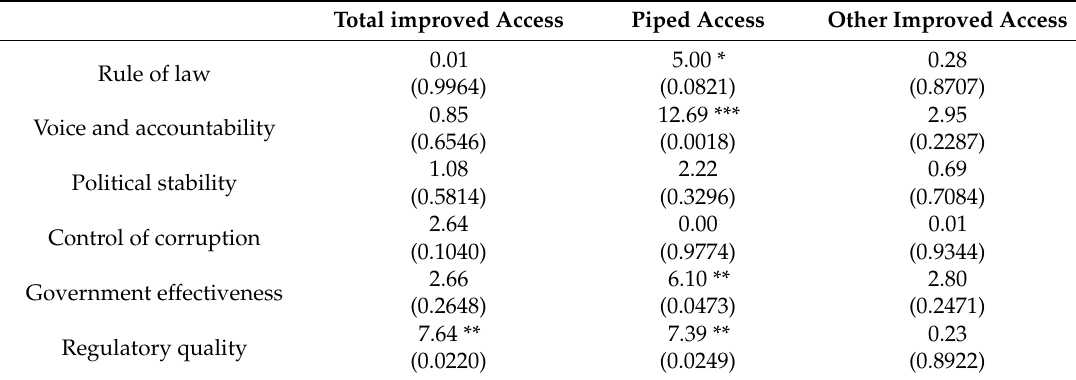
Table A6. Results of Wald test for low income